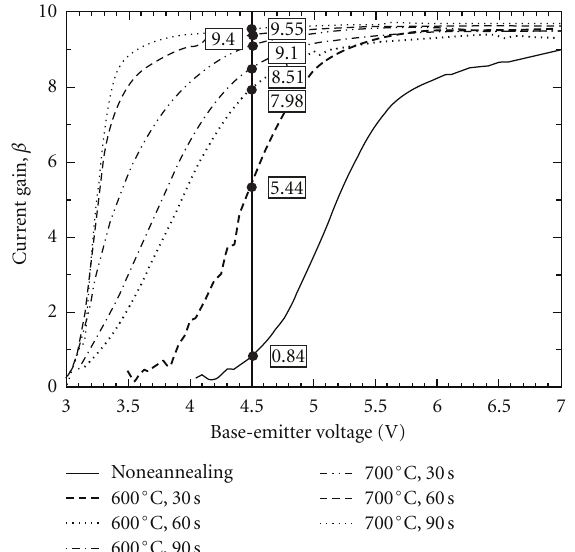
Figure 5: Current gain as a function of base-emitter voltage for all fabricated npn graded-base AlGaN/GaN HBT’s. A N-HBT’s is also included for comparisons.